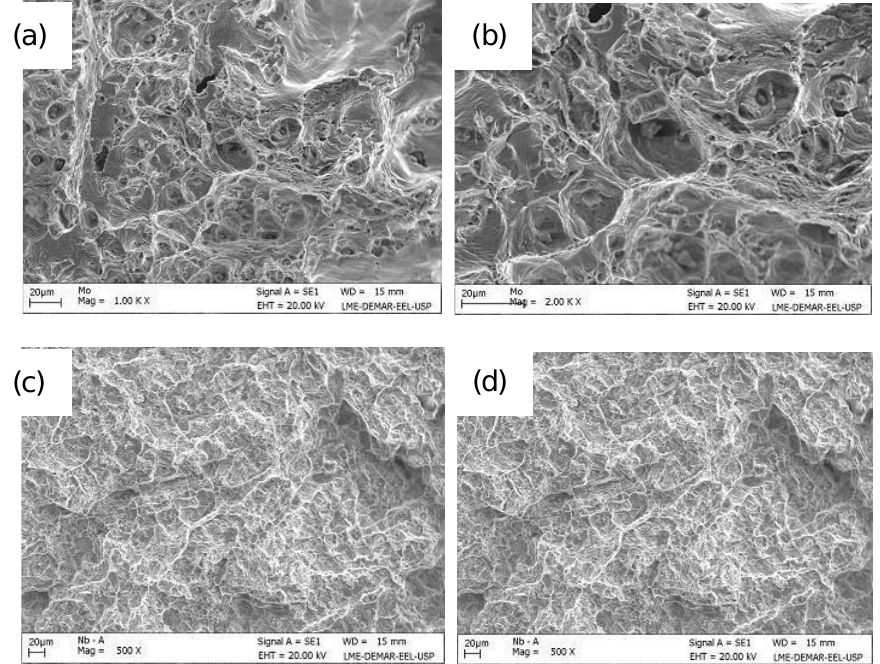
Figure 6. SEM fractographies of the as-cast ( a , b ) Ni-22Cr-10Mo and ( c , d ) Ni-20Cr-12Nb alloys after tensile tests.